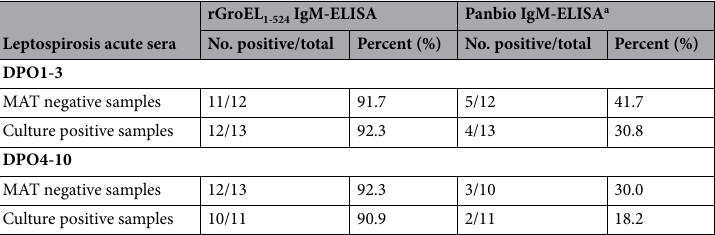
Table 2. Diagnostic sensitivities of rGroEL 1-524 IgM-ELISA and Panbio Leptospira IgM-ELISA on MAT negative (≤ 1:50) acute samples of sero-conversion leptospirosis cases and culture-positive acute sera on DPO1- 3, and DPO4-10. a Optimized cut-off for Panbio IgM-ELISA was ≥ 7